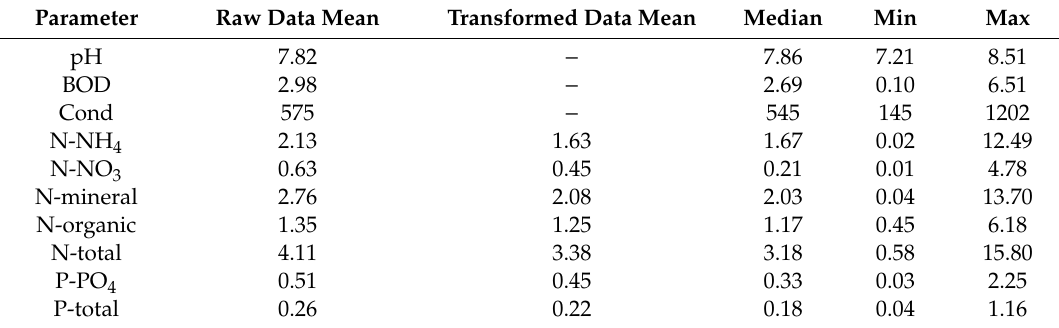
Table 2. Chemical characteristics of the surveyed rivers (Transformations are given in Table 1).